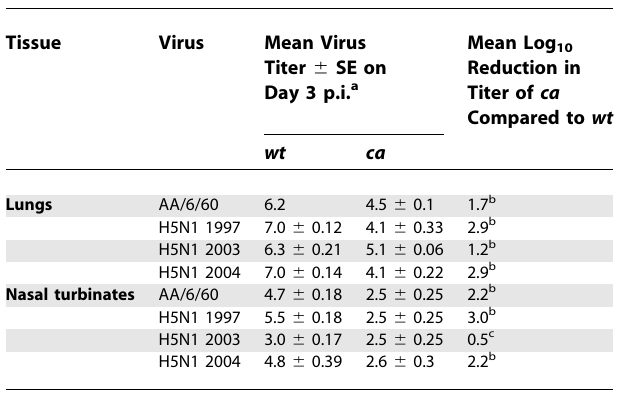
Table 3. The H5N1 ca Viruses Are Restricted in Replication in the Respiratory Tract of Mice